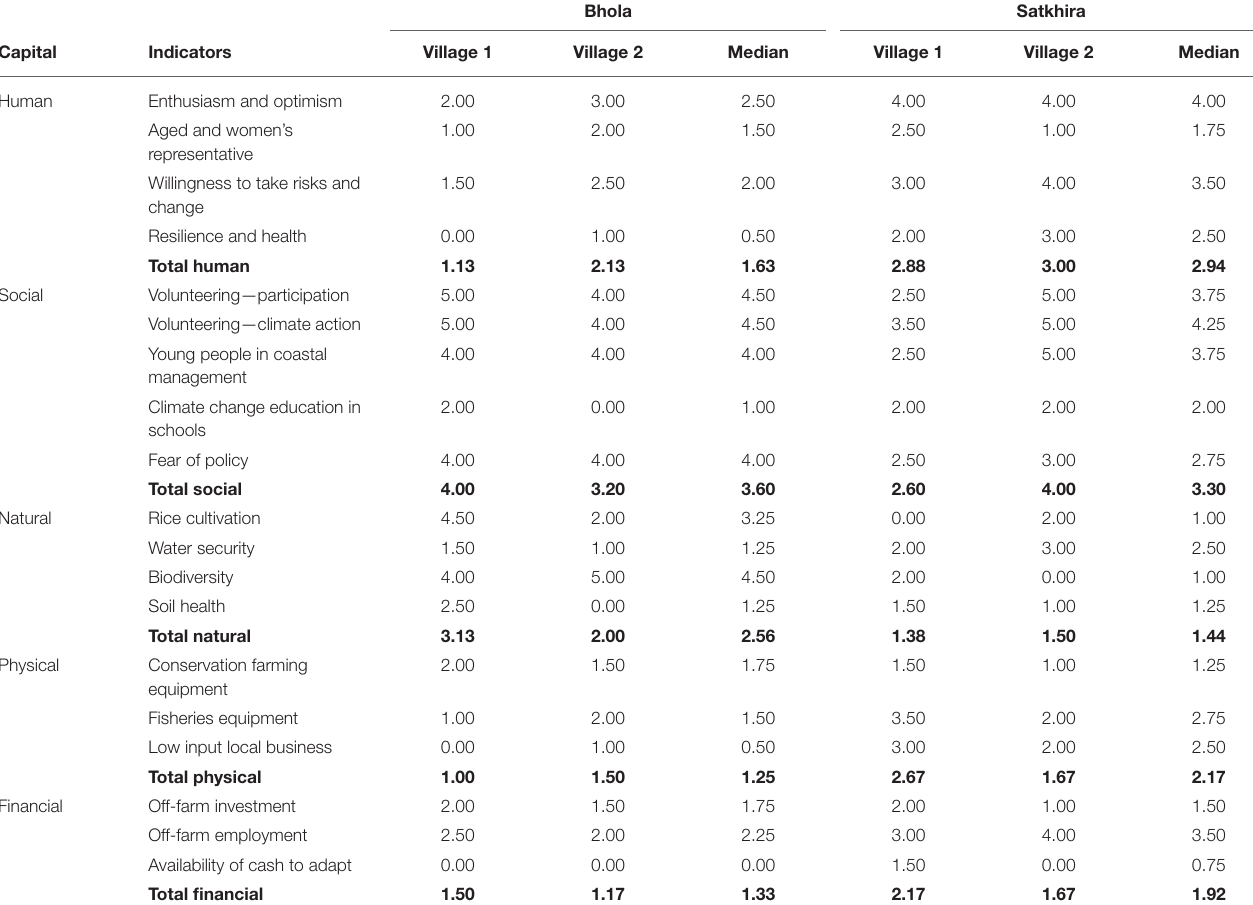
TABLE 1 | Assessment of adaptive capacity of a Coastal Island (Bhola District; left) and a Coastal Estuary (Satkhira District; right) of